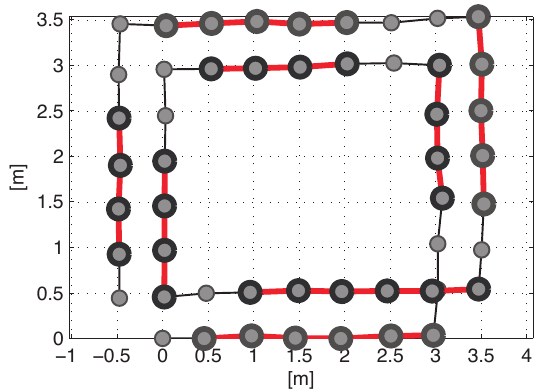
Figure 13. Optimized trajectory after pruning the false